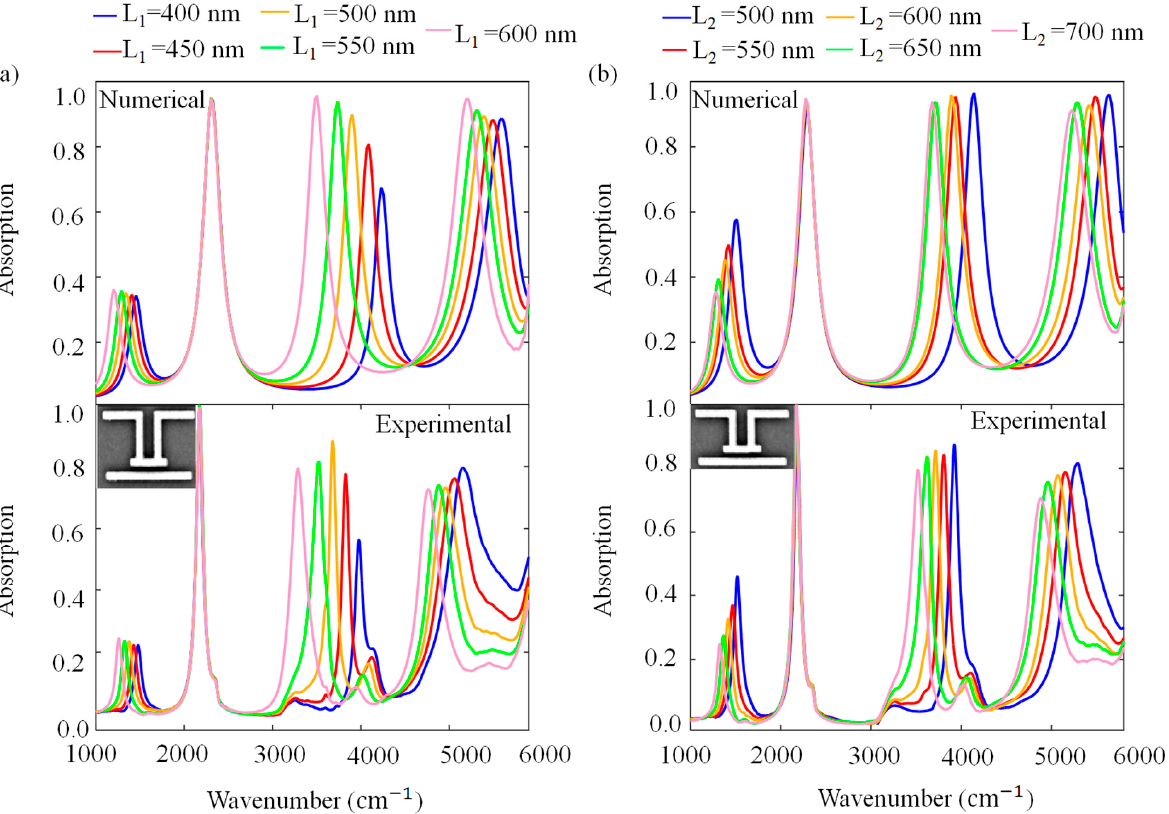
Figure 3. Absorption spectrum of the PA platform for ( a ) numerical and experimental L 1 sweep; ( b ) numerical and experimental L 2 sweep under the x-polarized light source. The insets show the SEM image of unit cell for L 1 = 400 nm and L 2 = 550 nm. Array periodicity is 1.7 µm.